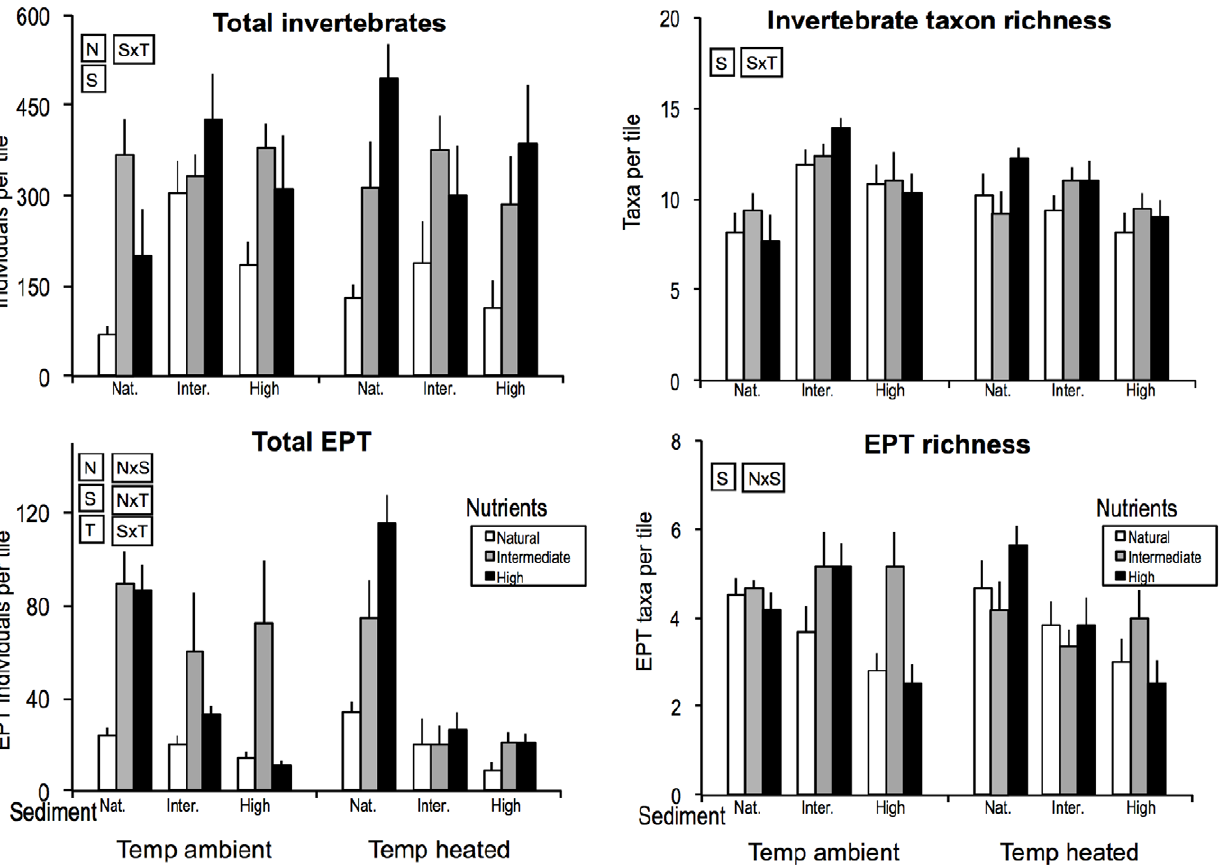
Figure 1. Averages of invertebrate community variables across the experimental treatments sampled on days 18 and 30 combined. Error bars (SEs) show the within-channel variation (n=3) that is represented by the factor ‘sample’ in the statistical analysis (see text). Text in rectangles indicates significant single-factor effects (nutrients: N, sediment: S and temperature: T) or interactions.